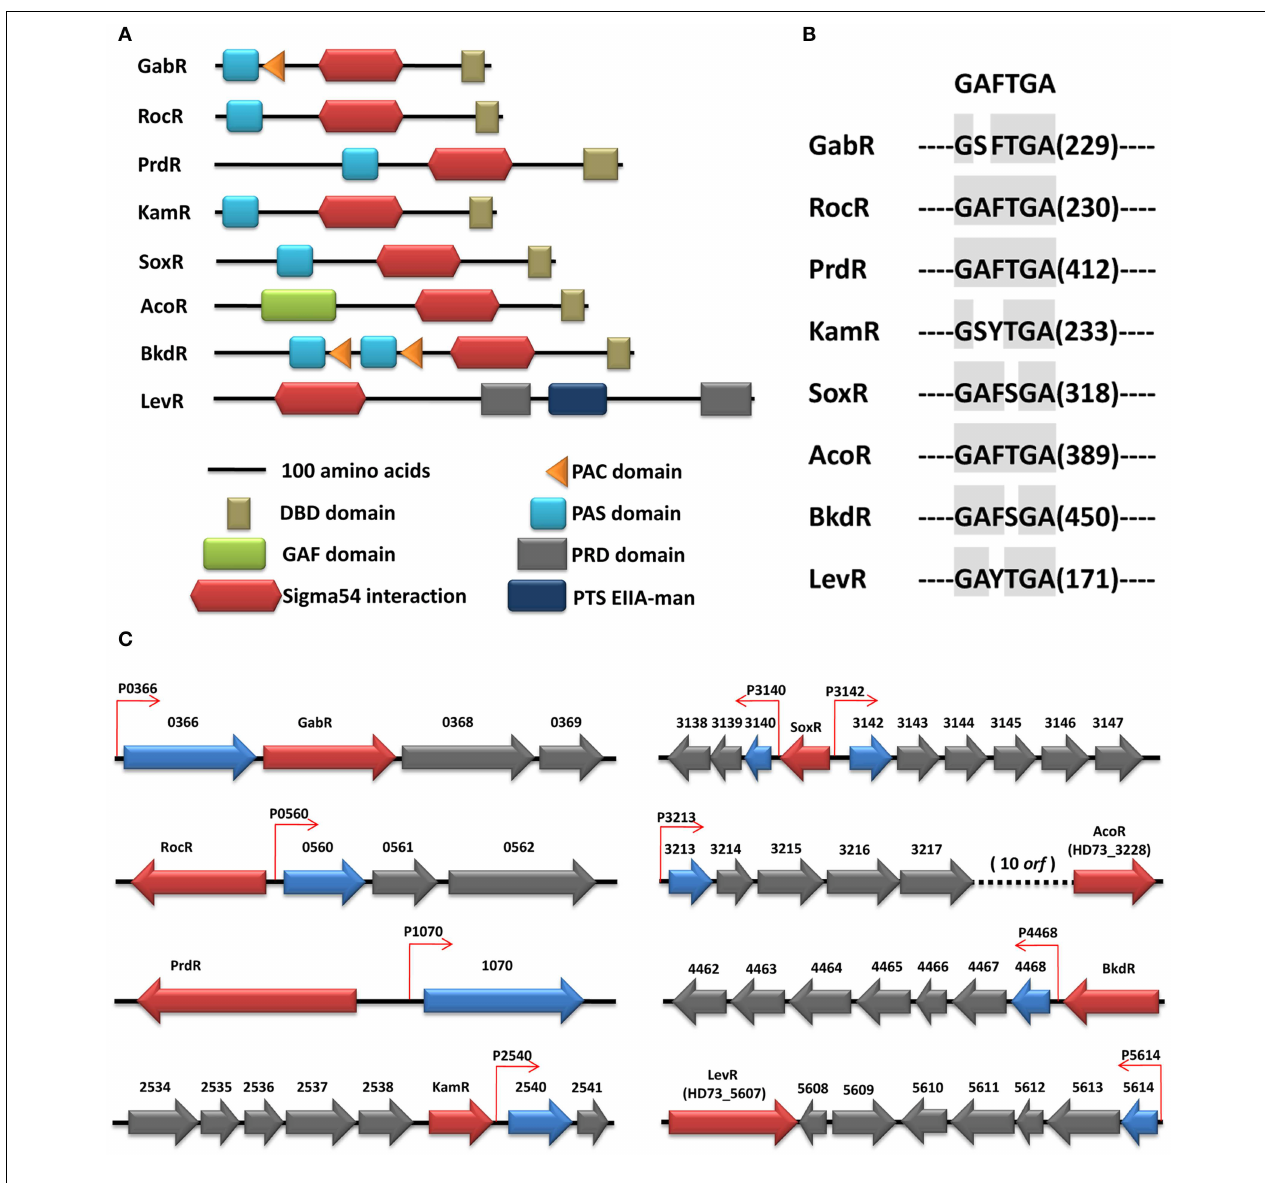
FIGURE 3 | (A) Domain structure of the EBPs in the Bt HD73 genome. The type of domains is indicated. All proteins are drawn at the scale indicated. (B ) Conserved domain of the EBPs. The number indicates the distance between the conserved domain relative to the first amino acid. (C) Chromosomal context of EBPs in the Bt HD73 g enome. The